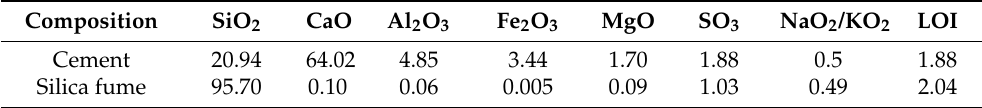
Table 1. CSHWMs of cement and silica fume